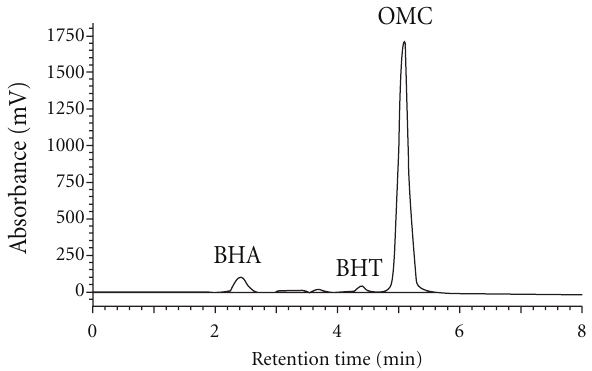
Figure 7: Chromatogram of BHA, BHT, and OMC in Nivea milk lotion sample using RP-HPLC-UV/Vis at λ max = 280nm.